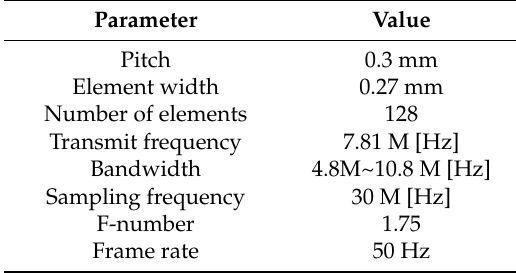
Table 1. Experimental imaging